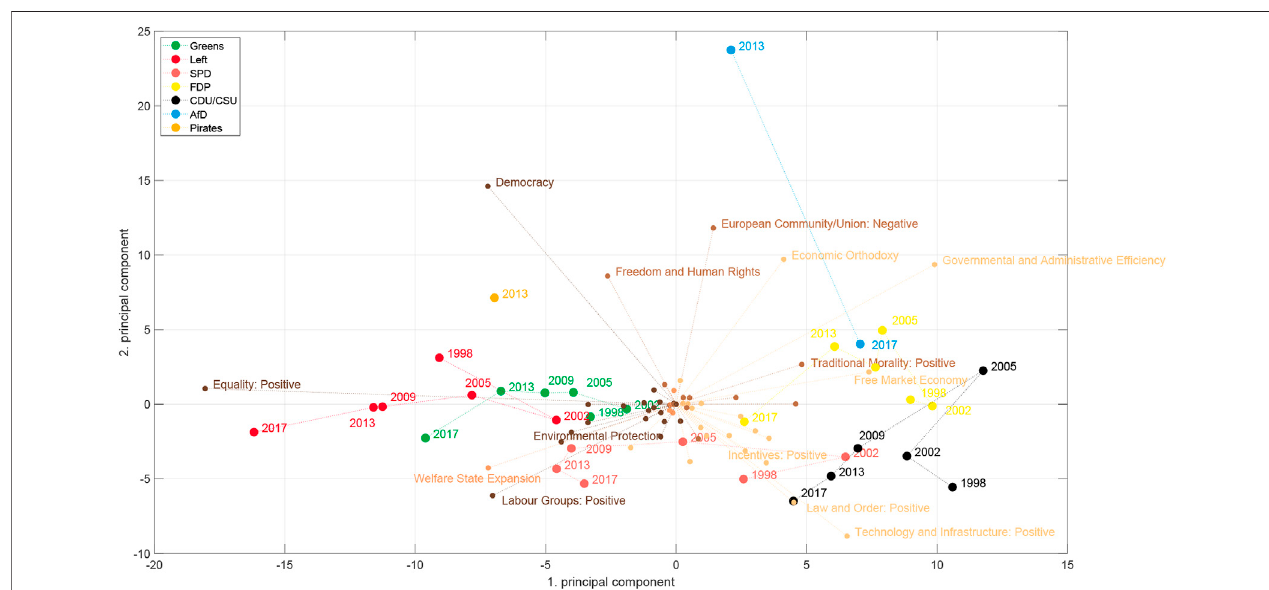
FIGURE7| FirsttwoprincipalcomponentsforthepoliticalestimatedfromtheMARPORcategoriesforGermany1998 – 2017.Forthepartypositionsitisidenticalto Figure 3A .Here weshow additional thedirections oftheissues inthisspace.Note thatonly the relative lengthofthe issuevectors aremeaningful. Forbetter readability, the labels are only shown for issues with suf fi ciently large projections in this space. The colors (different copper tones) indicate to which of the three issue bundles the issues belong.